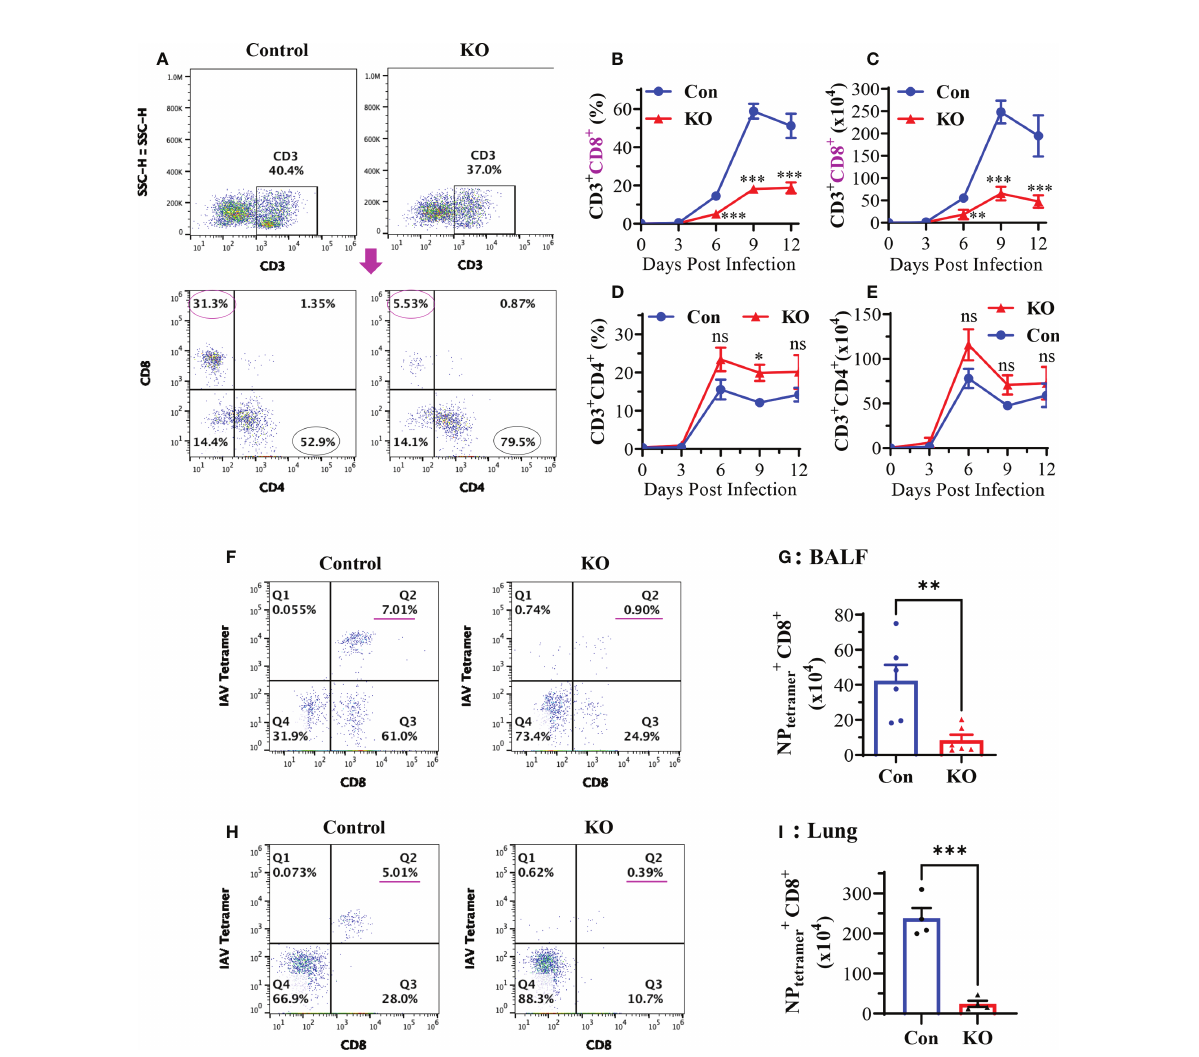
FIGURE 5 KO of Runx3 in adult mice profoundly reduces CD8 + cytotoxic T cells in IAV-infected lungs. Sex- and age-matched littermate control (Con) and fl ow cytometry analysis. (A – Runx3 KO (KO) mice were infected with 1 LD 50 of H1N1 PR8 strain, and BALFs were collected and subjected to E) KO of Runx3 markedly reduces total pulmonary CD8 + cytotoxic T cells in response to IAV infection. CD8 + and CD4 + T cells were identi fi ed based on the selected surface markers from the CD3 + -gated cell populations, and the cell frequencies (B, D) and absolute numbers (C, E) were shown in the bar graphs. A representative FACS plot evaluated on day 6 pi is shown in (A) . Results are presented as means ± SE. Days 0 and 3 pi, n = 3; days 6 to 12 pi, n = 6-10. (F – I) Profound reduction of pulmonary NP-speci fi c CD8 + cytotoxic T cells by Runx3 KO. H2D b MHC class I tetramer of IAV NP 366-374 and CD8 antibody were used to identify the NP 366-374 -speci fi c CD8 + effector T cells( NP + tetramer CD8 + ) in BALFs (F-Q2) and whole lungs (H-Q2) as shown in representative FACS plots evaluated on day 9 pi. The NP + tetramer CD8 + T cell numbers in BALFs (G) and whole lungs (I) were shown in bar graphs. Results are presented as means ± SE (n = 4-6). Two-way ANOVA and unpaired Student ’ s t test were performed in (B – E) and unpaired Student ’ s t test was performed in (G, I) . *p<0.05; **p<0.01; ***p<0.001 vs control mice. NS, not statistically signi fi